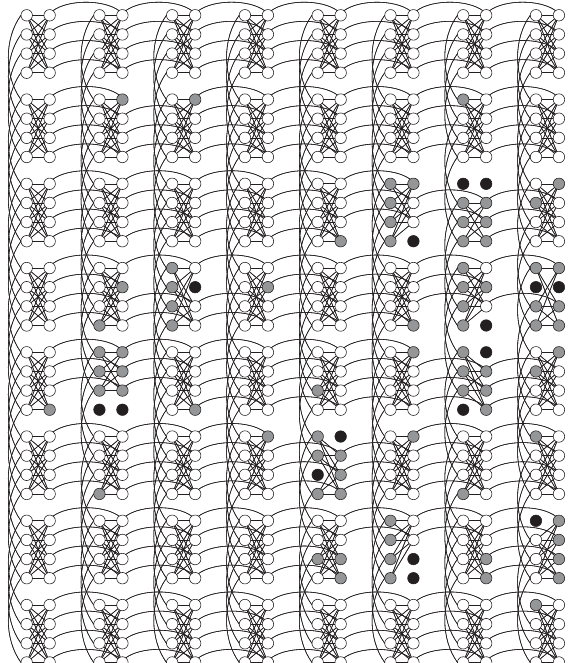
FIG. 7. Adjacency matrix of the D-Wave Two chip used in this study. Circles represent the individual qubits and lines the couplers. White circles represent fully functional qubits, whereas light gray circles represent working qubits with missing couplers. Broken qubits are represented by dark circles (16). This means that the total number of working qubits is 496.